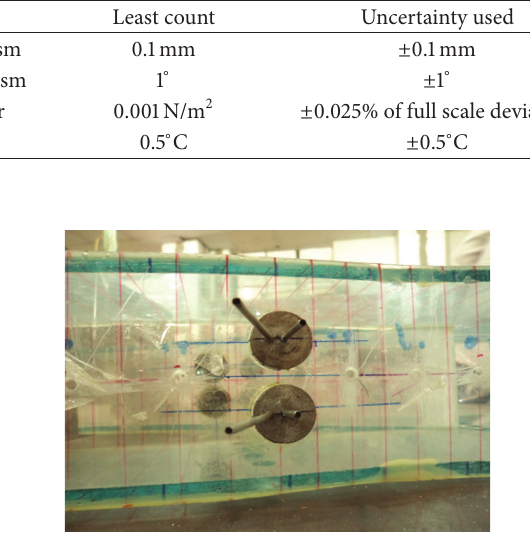
Figure 6: Location of VGJ on the side walls of the air-intake.